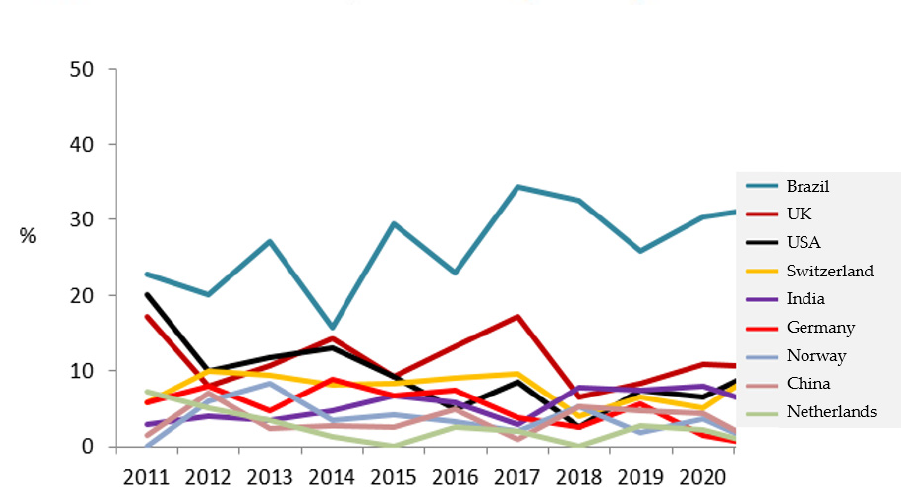
Figure 4. Origin of the articles published during the 10 years of the studied period.